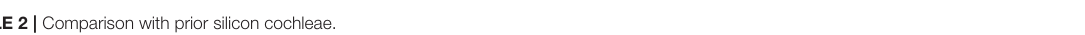
TABLE 2 | Comparison with prior silicon